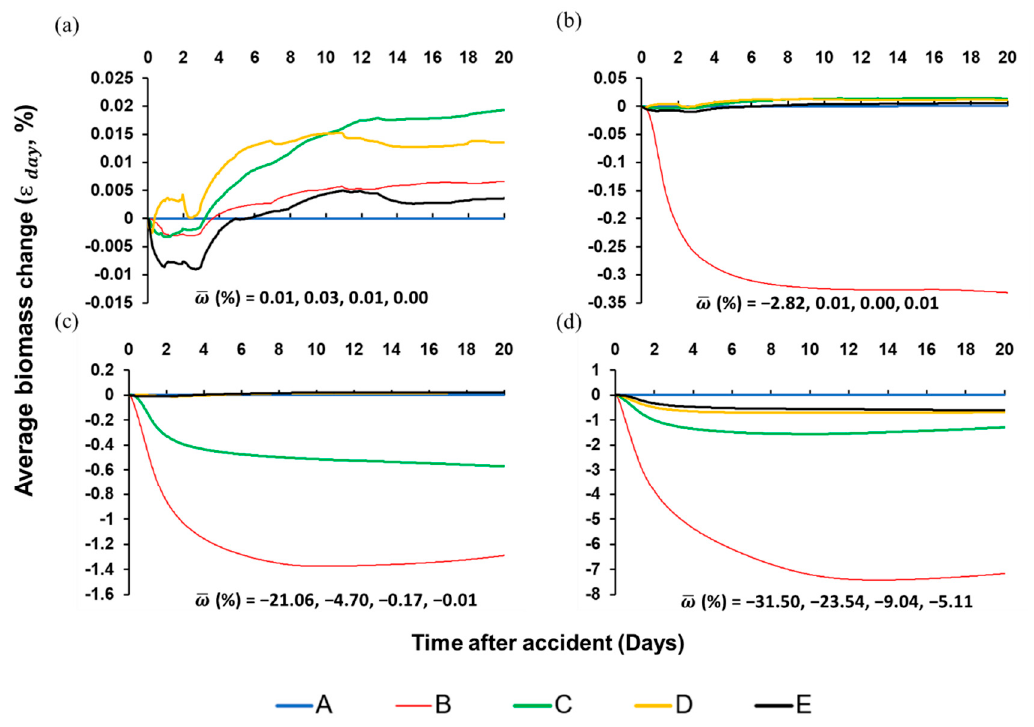
Figure 4. Average biomass change ( ε days , %) of total biomass of organisms in the Jeonju River for ( a ) 30 kg spill, ( b ) 300 kg spill, ( c ) 3000 kg spill, and ( d ) 30,000 kg spill of toluene. Each different color line designates each segment A, B, C, D, and E. Average biomass change (%) means relative change of total biomass of organisms in each segment.